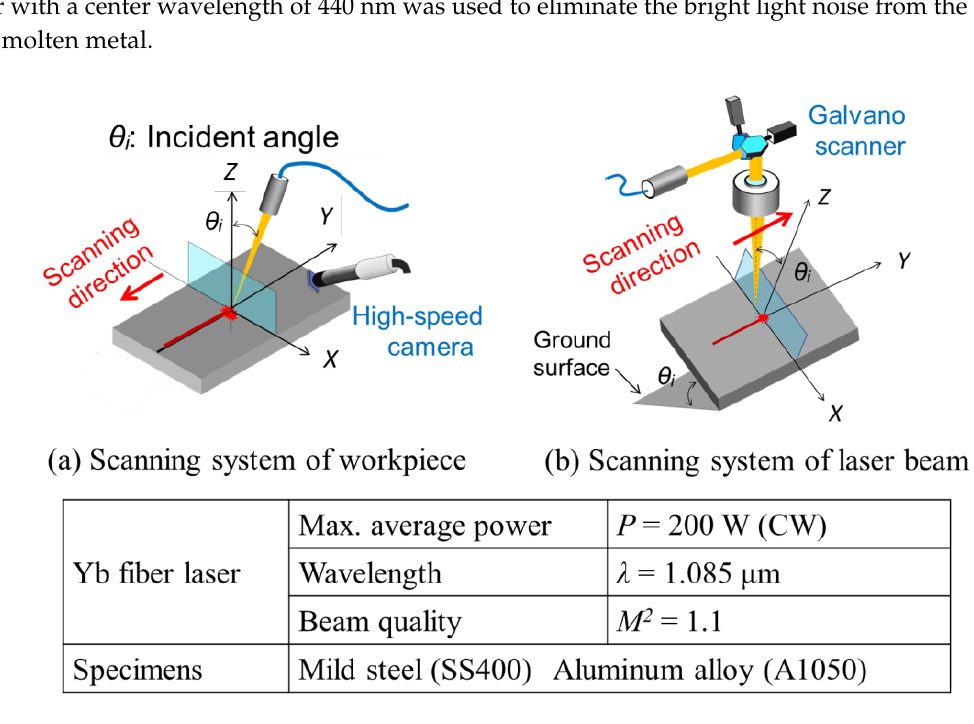
Figure 1. Schematic diagrams of experimental setups.